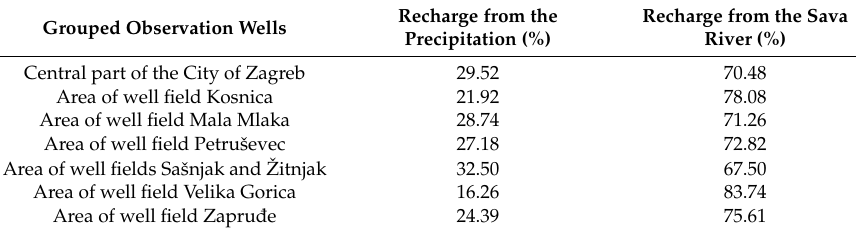
Table 5. Average recharge in different soil types in the area of the Zagreb aquifer.